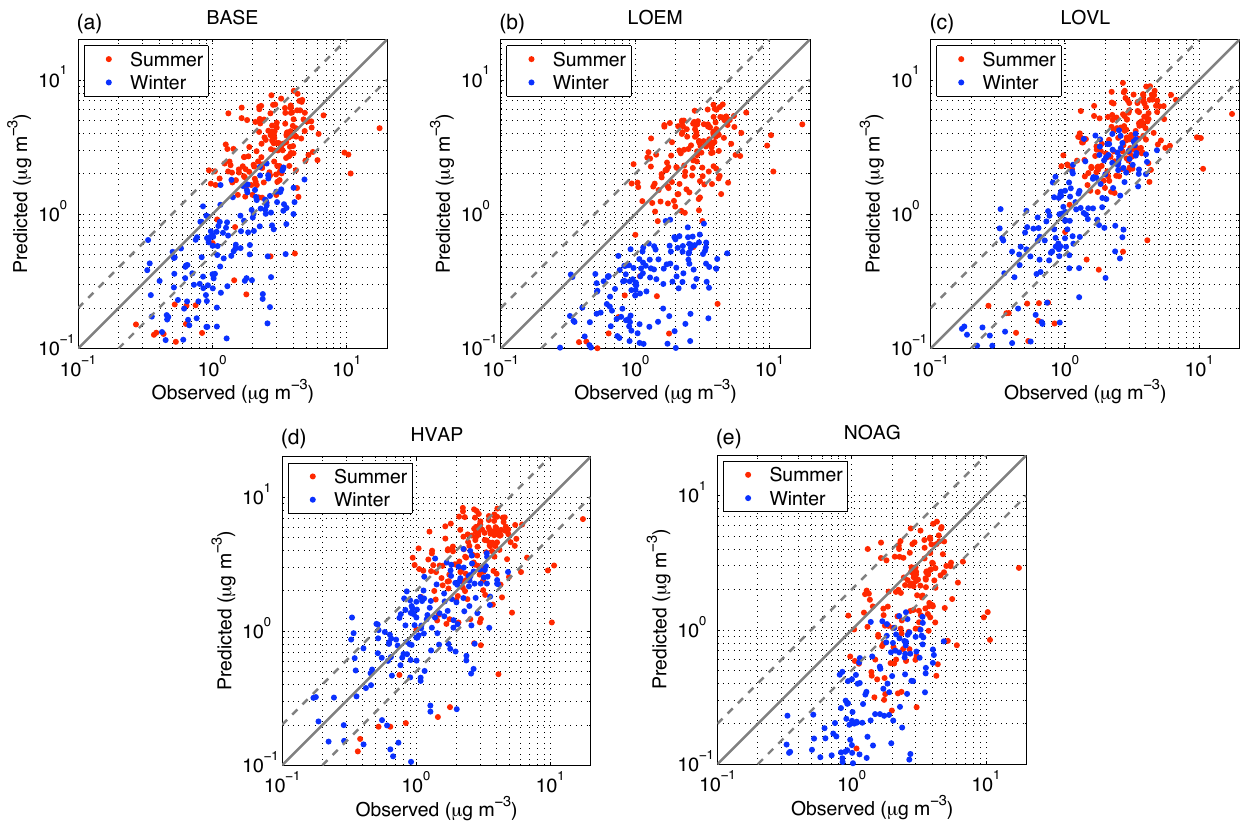
Fig. 7. Scatter plots comparing model predictions from BASE, LOEM, LOVL, HVAP and NOAG with observations at IMPROVE sites from the 2001 to 2002. Red represents the summer months of June, July and August (JJA) and blue represents the winter months of December, January and February (DJF). The solid grey line is the 1:1 line and the dashed lines are the 1:2 and 2:1